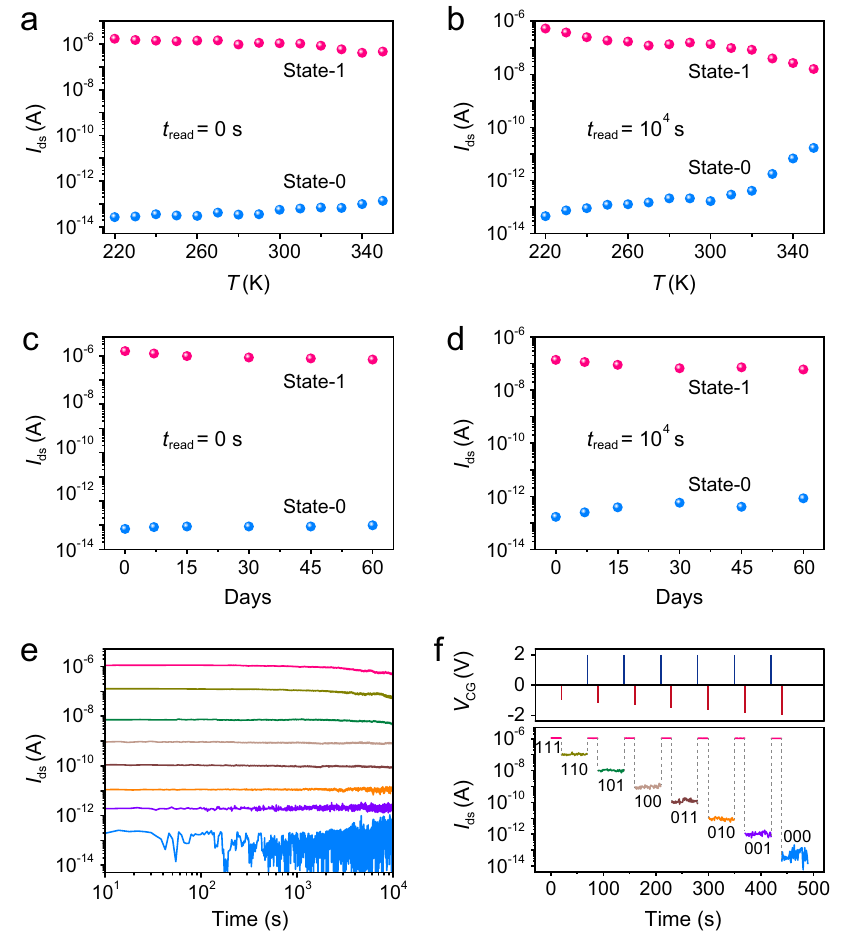
writing/erasingoperations( c )andafter10 4 sretention( t read =10 4 s)( d ). e I – t curves of the memorydevice ateight distinctconductive levelsfor 10 4 s. f Realization ofa 3-bit (8 storage levels) memory by applying 20ns V CG pulses with amplitude ran- ging from – 1V to – 2V. All the channel currents in a – f were read with a fi xed V ds of 0.1V at V CG